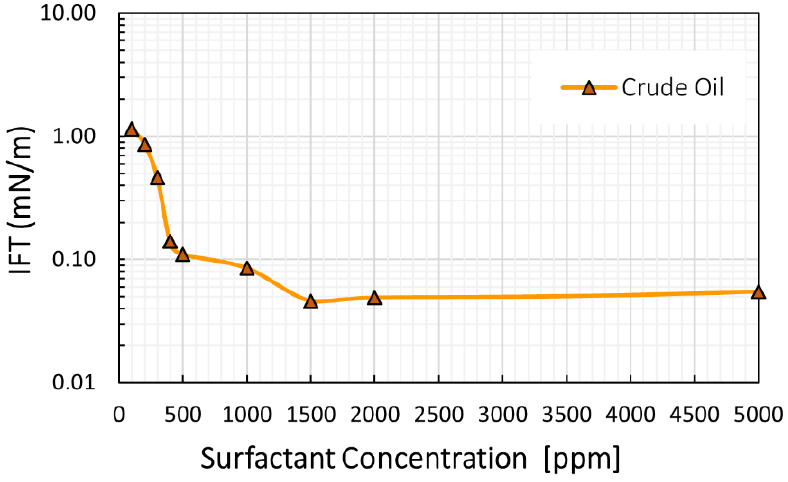
Figure 3. Oil – water IFT as a function of surfactant concentration. Figure 3. Oil–water IFT as a function of surfactant concentration.